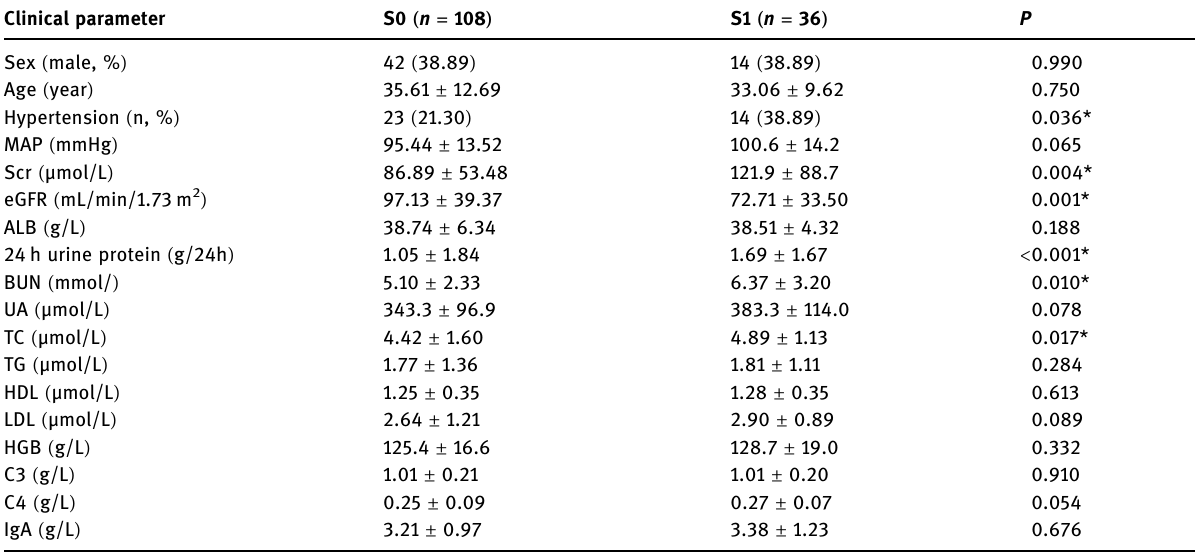
Table A3: Relationship of S score with clinical parameters of patients with IgAN Clinical